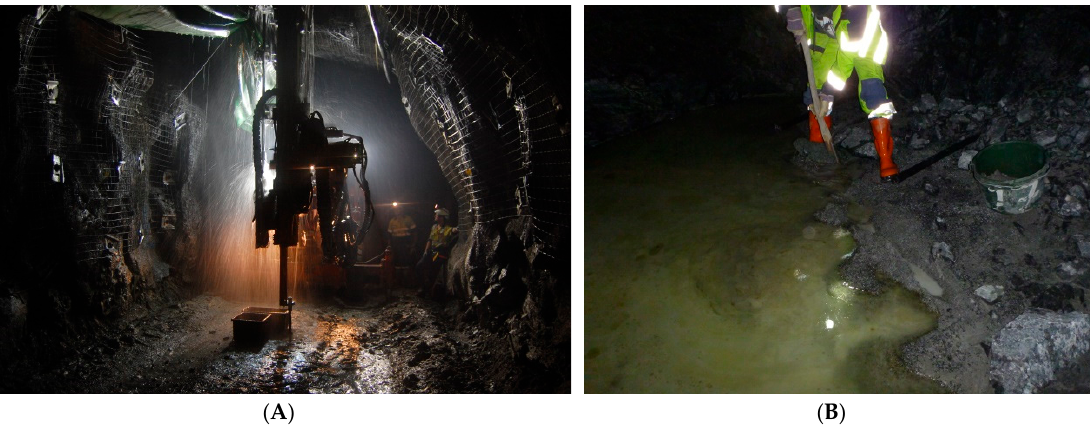
Figure 8. Types of sludge sampling. ( A ) Collection of stope blasthole sludge via plastic boxes placed below the hole leads to very high DE and EE; ( B ) Collection of face blasthole sludge via scooping from the drive floor leads to high FSE, GSE, DE, and EE.